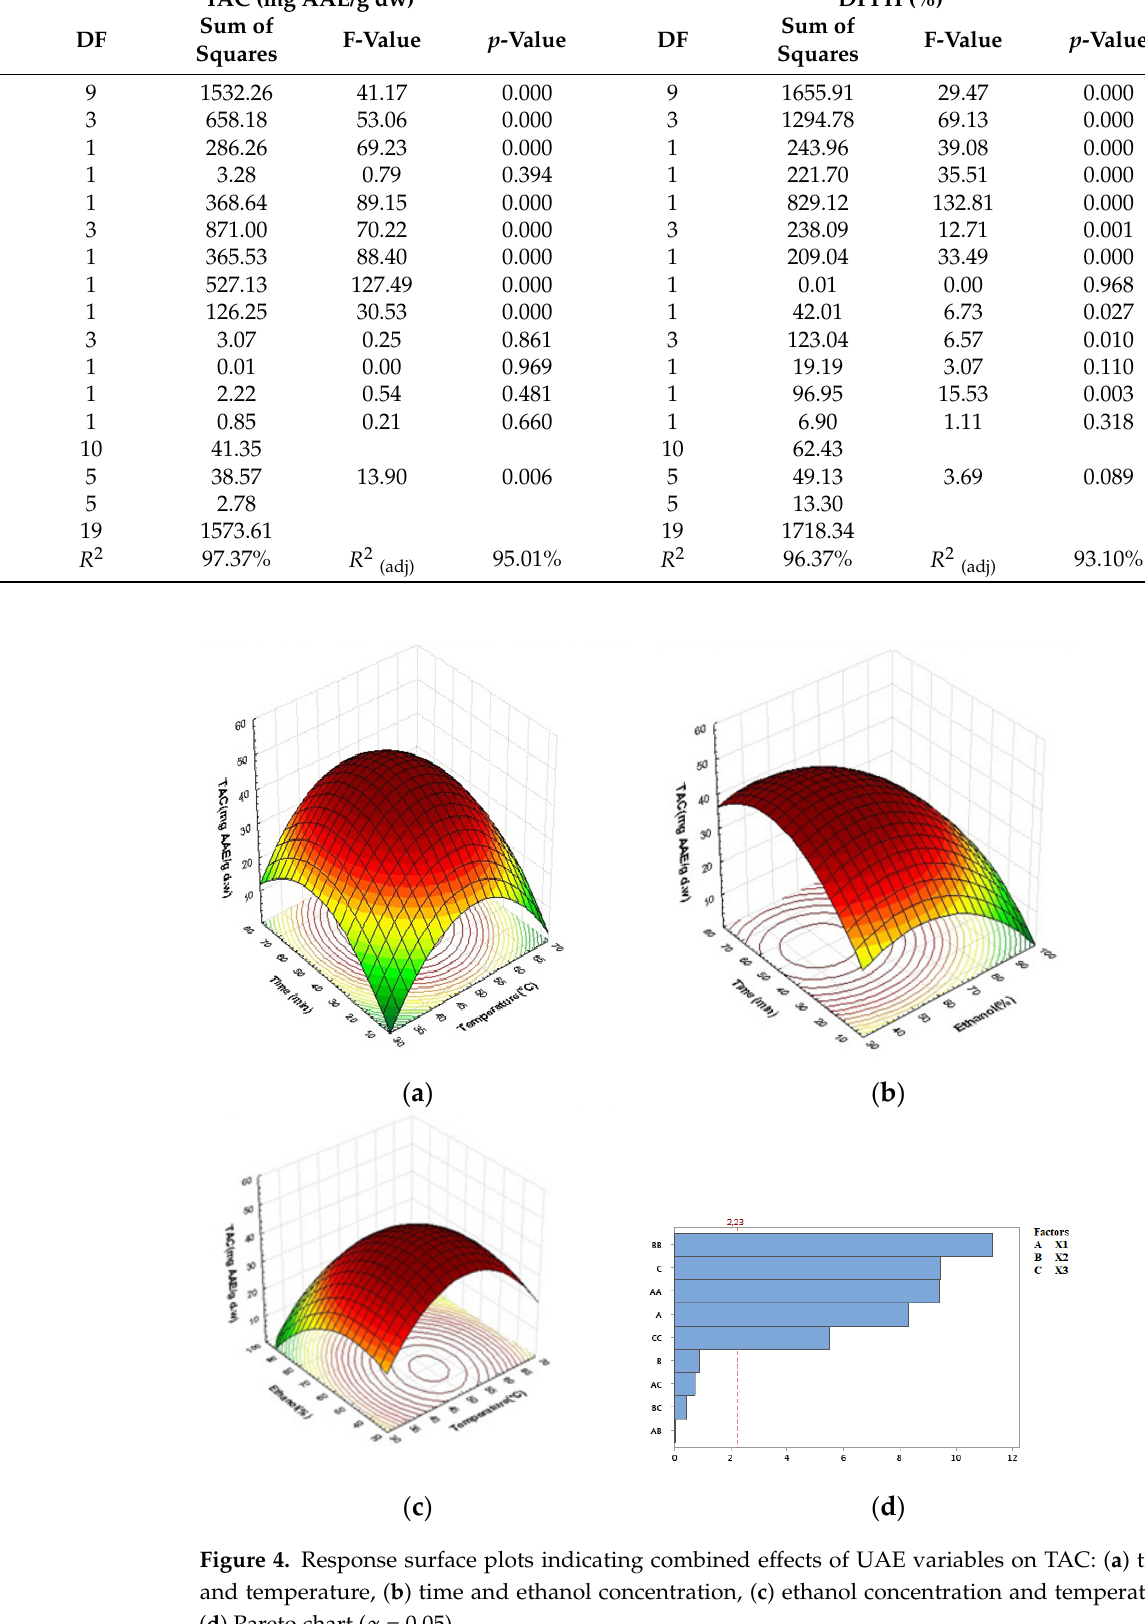
Table 3. ANOVA for evaluation of the total antioxidant capacity (TAC) and DPPH method. TAC (mg AAE/g dw) DPPH (%)